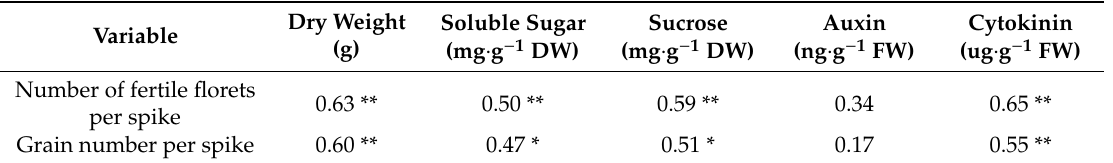
Table 1. Relationships among spike dry weight, sugar content, hormone content, and number of fertile florets per spike and grain number per spike at anthesis for two growing seasons of 2016–2018 ( n = 6). Significant at * p = 0.05, ** p =